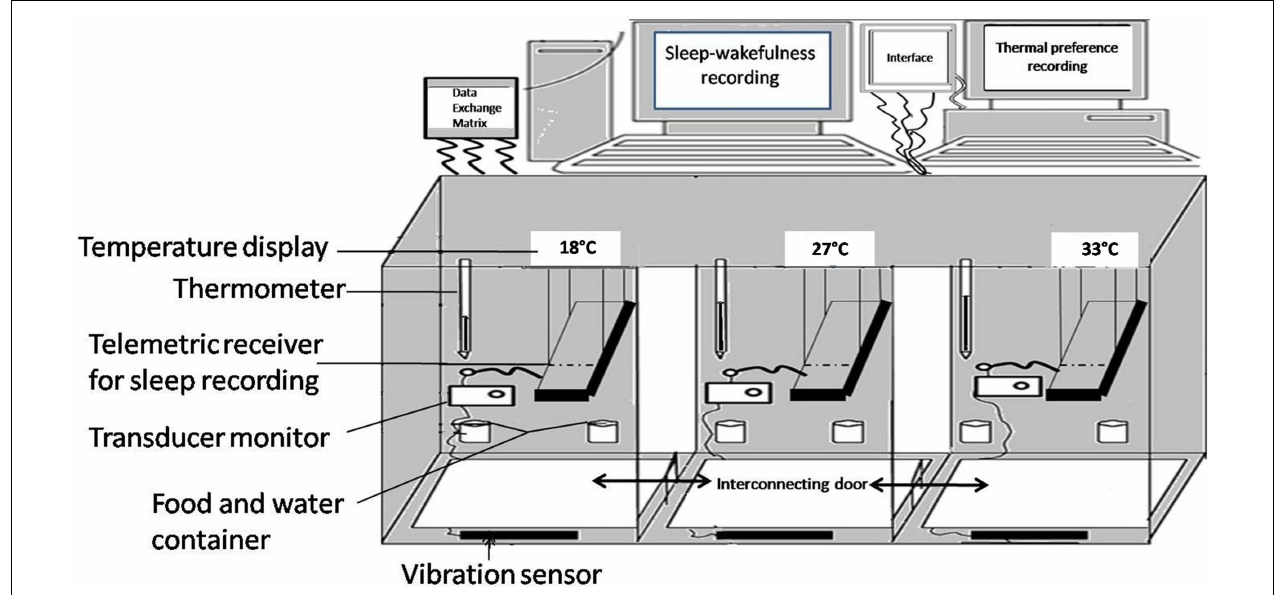
FIGURE 1 | Schematic diagram of environmental chamber having three different ambient temperature (18, 30, and 33˚C) in the three interconnected compartments.